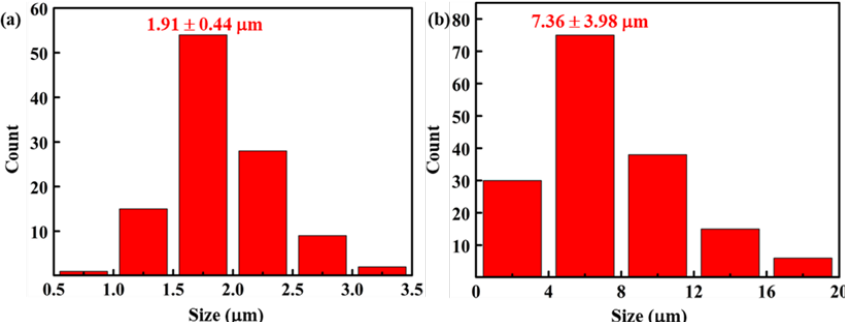
Figure 4. The particle size distributions of ZrB 2 : ( a ) C/C–ZrB 2 preform; ( b ) ZrB 2 -composite.